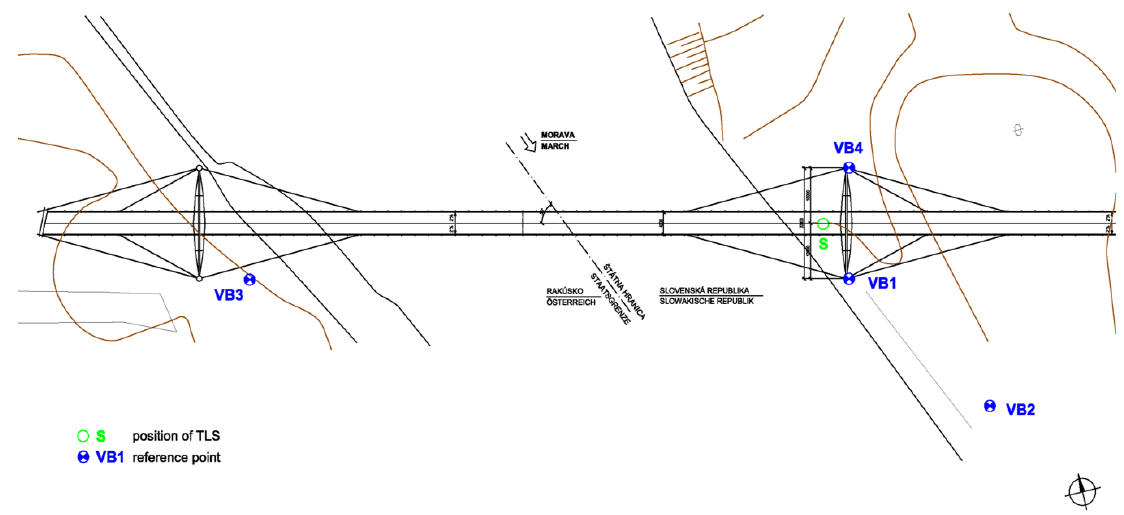
Figure 6. Position of the laser scanner and the reference points.